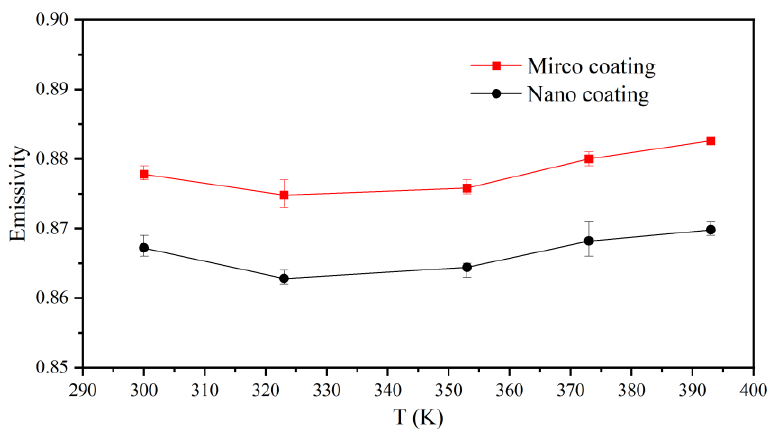
Figure 12. The temperature dependence of the emissivity ( ε ) of Al 2 O 3 coatings in 1–22 µ m wave- bands.